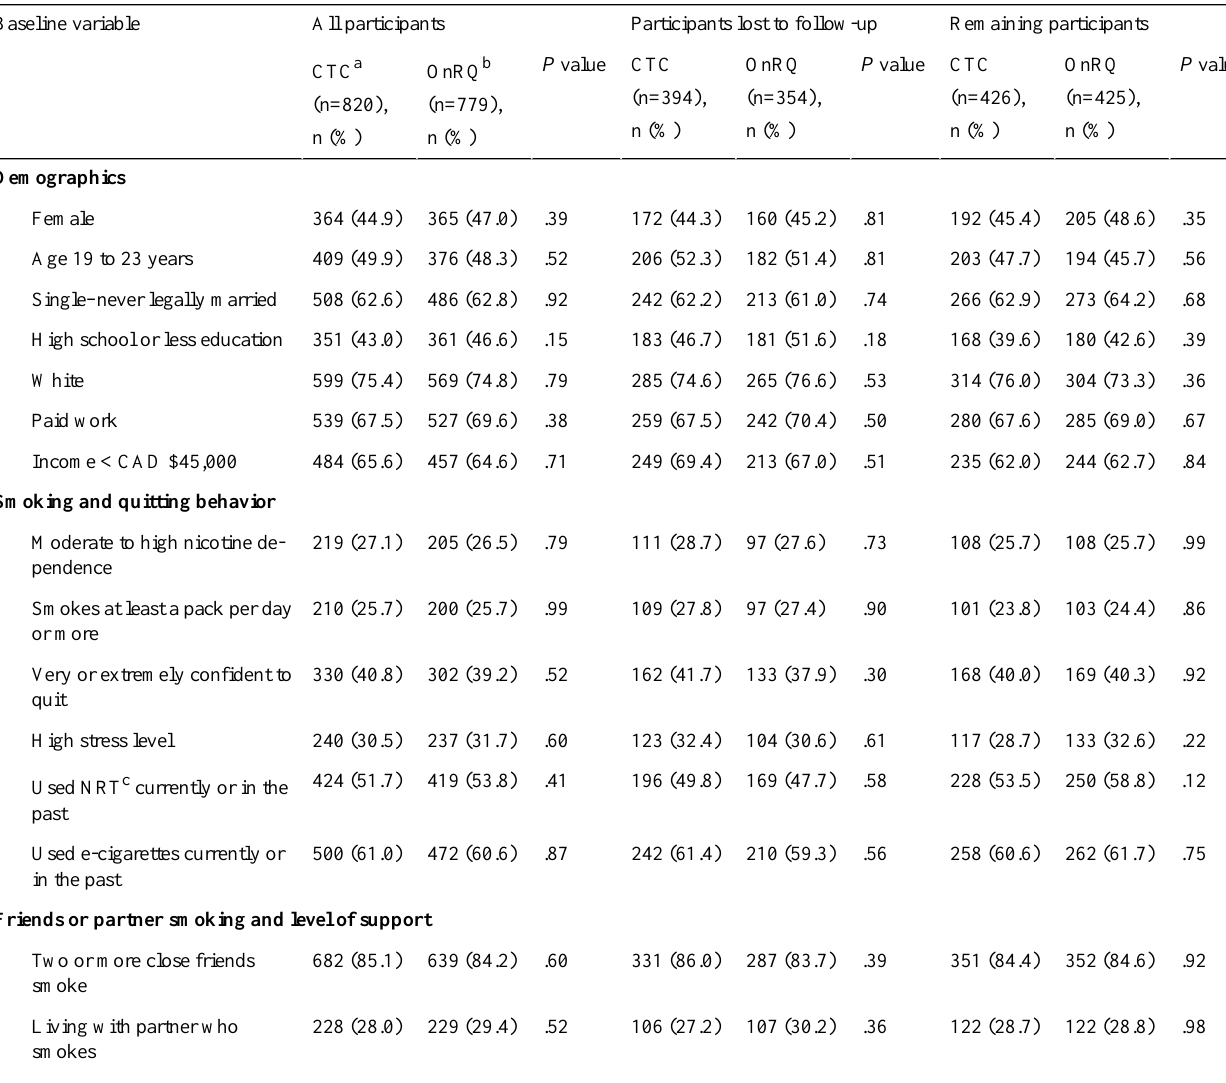
Table 1. Baseline characteristics of participants randomized to each arm, those lost to follow-up, and those remaining at 6 months.